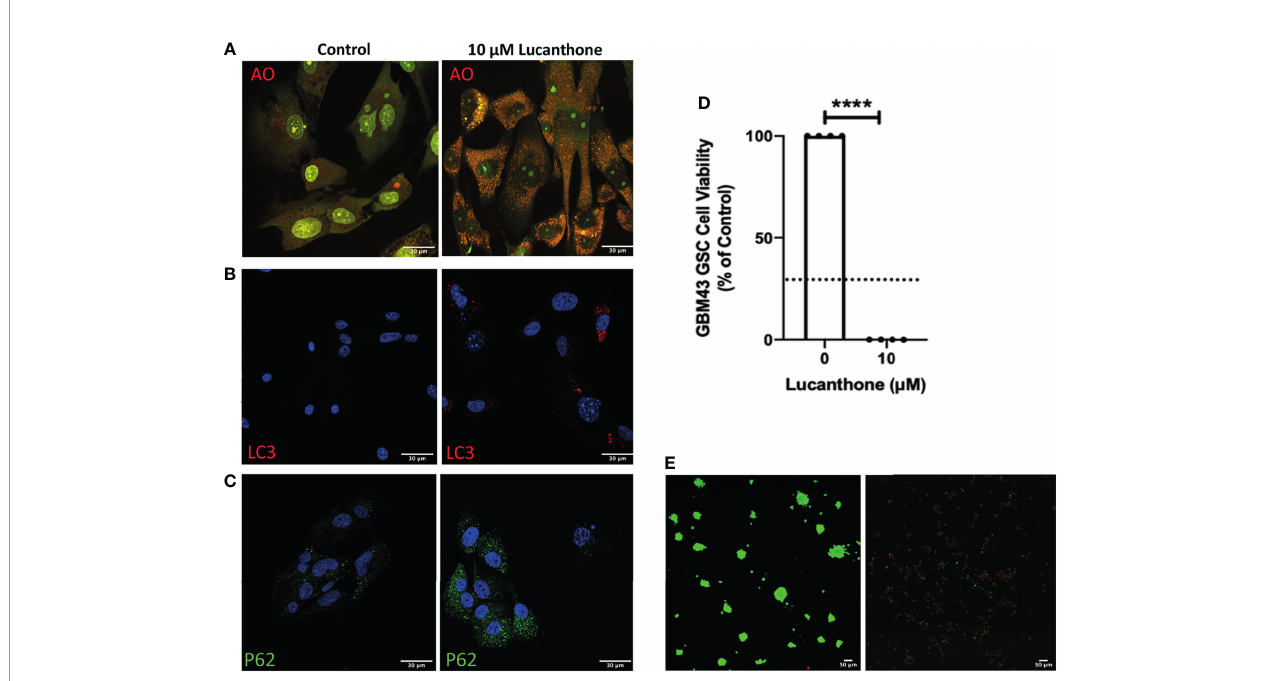
FIGURE 4 | Patient-derived glioma cells are susceptible to lucanthone. (A) GBM43 cells were treated with lucanthone and assessed for changes in acridine orange staining, (B) LC3 and (C) p62 levels. (D) GBM43 CSCs were treated with lucanthone for 5 days and then an MTT assay was performed. (E) GBM43 GSC were treated with media or lucanthone for 5 days, after which spheroids were visualized by Calcein-AM and Ethidium homodimer staining. Data are representative of 4 independent experiments. ****p < 0.0001, t-test. Dotted line represents culture viability prior to any